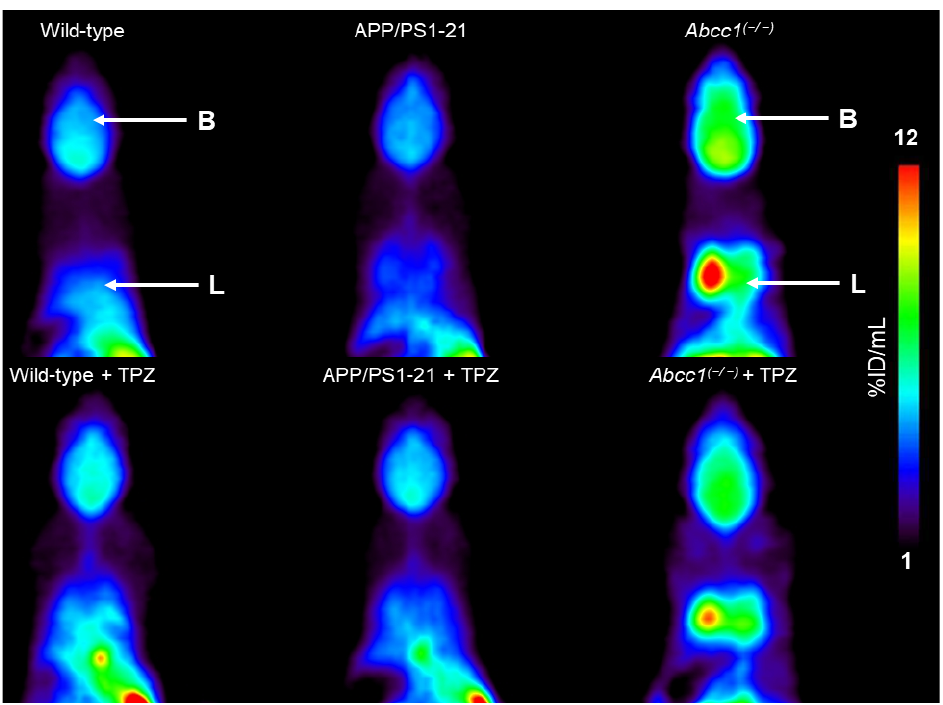
Figure 1. Representative coronal PET summation images (0 ‐ 90 min) of one wild ‐ type, APP/PS1 ‐ 21 and Abcc1 ( − / − ) mouse at baseline and following 5 ‐ day oral treatment with thiethylperazine (TPZ, 15 mg/kg, once daily). Anatomical regions are labeled with arrows (B, brain; L, lungs). Radioactivity concentration is expressed as percent of the injected dose per milliliter tissue (%ID/mL). All images are scaled to the same intensity (1 ‐ 12 %ID/mL).